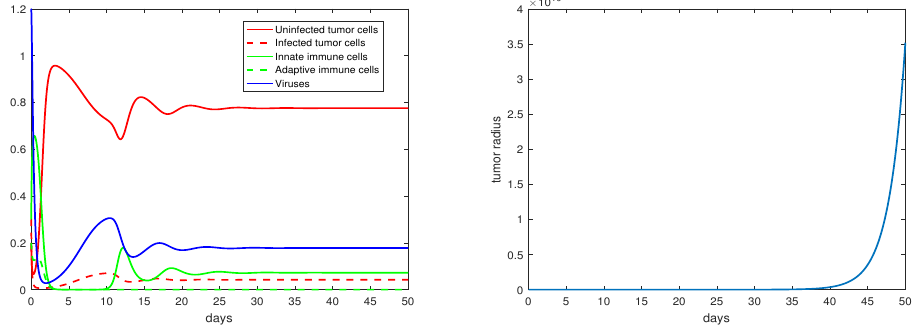
Figure 6. The equilibrium E 0 = ( 0,0.57,0,0,1.20 ) is asymptotically stable and the tumor radius is exponentially decreasing when δ < µ and min {R 0 = 2.10, R 1 = 2.06, R 2 = 1.85 } > µ values of the parameters are: λ = 2, β = 3.5, k 1 = 1, k 2 = 2, s 1 = 2, s 2 = 1.5, c 1 = 3, c 2 = 2.5, δ = 1.5, k 0 = 1.5, γ = 2.5, µ = 3.5, b = 3.5.